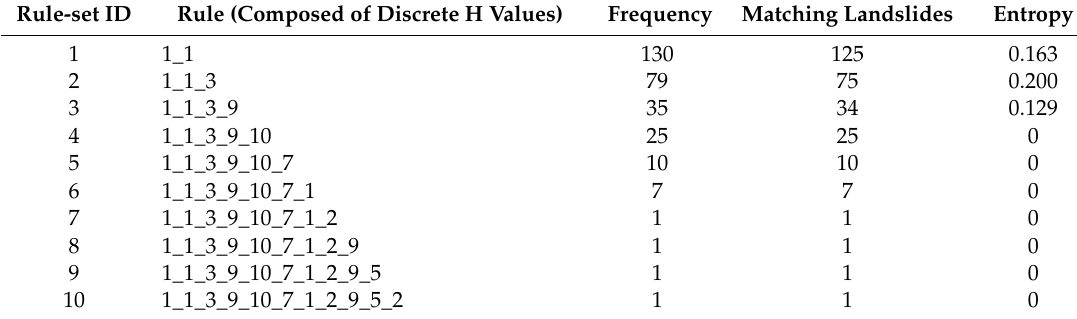
Table 3. Accuracy metrics of implemented LSMs for Northwest